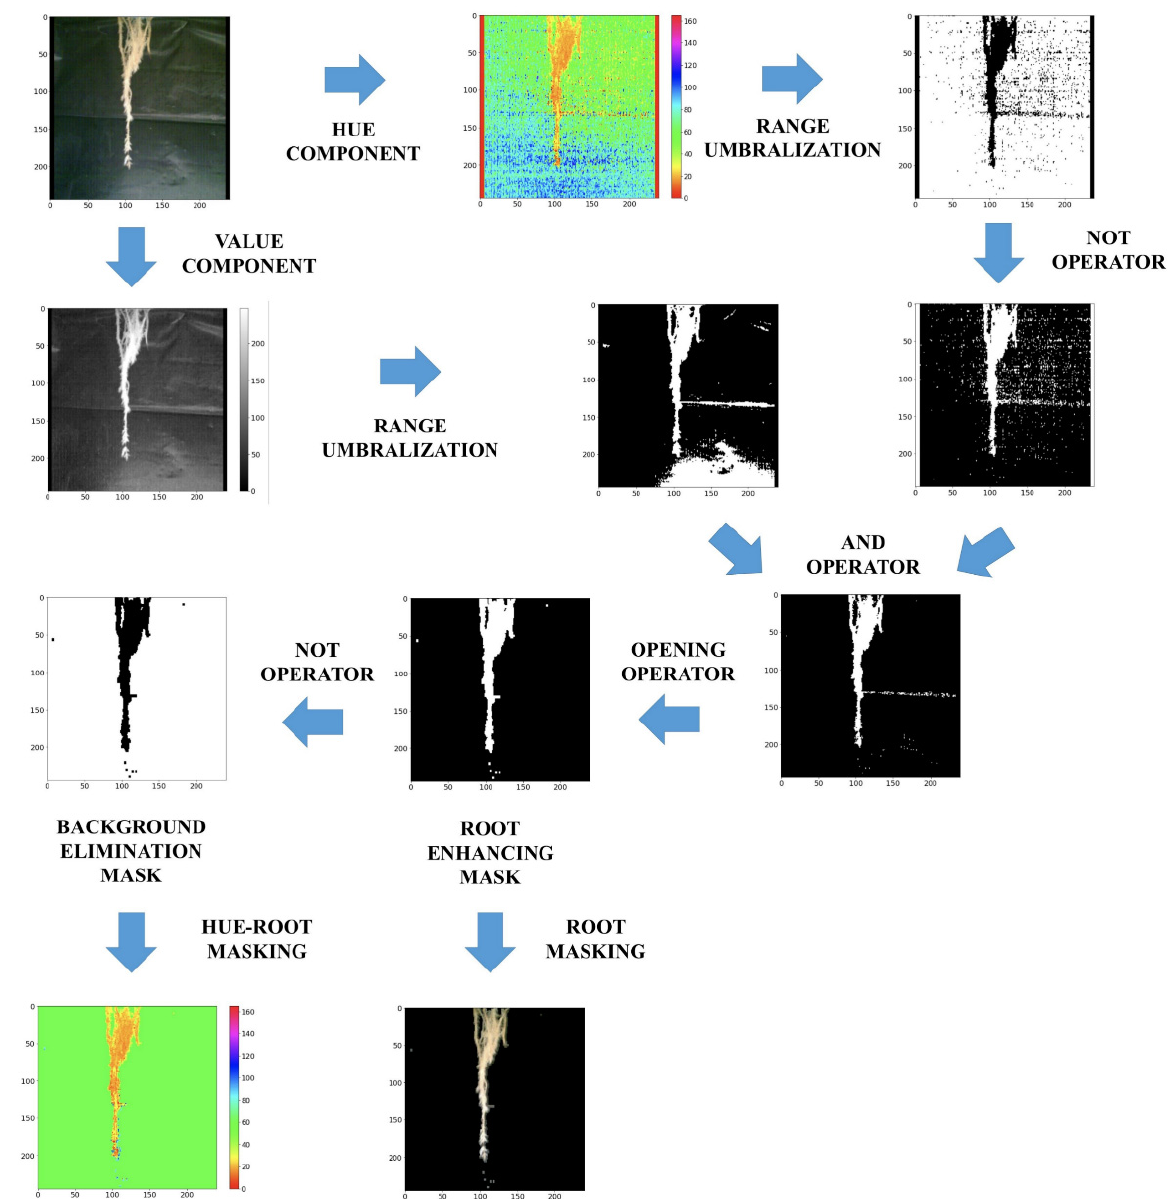
Figure 13. Image processing for root enhancement.